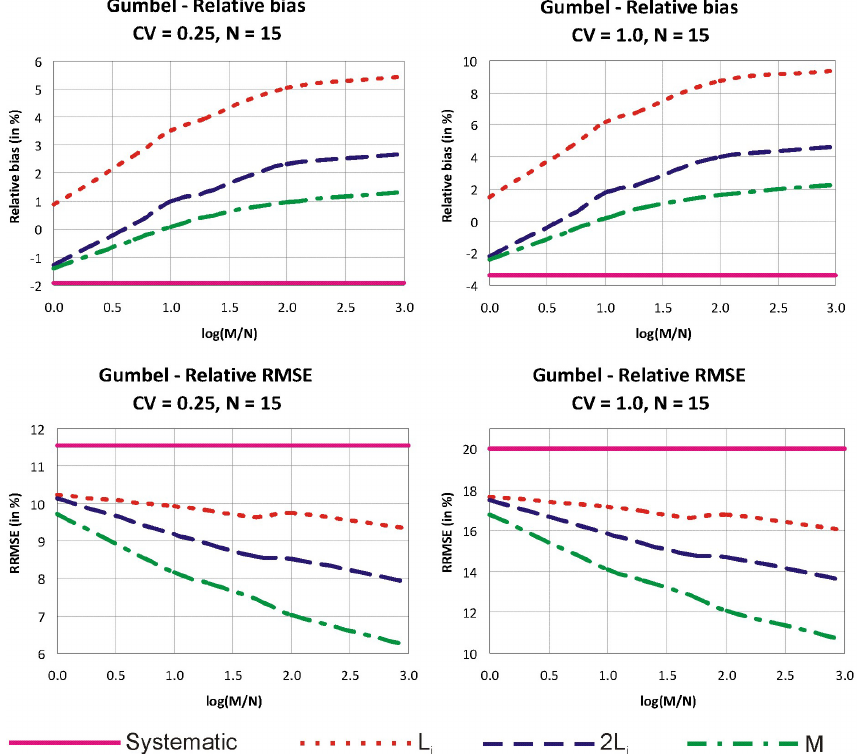
Figure 2. Relative bias (RB) and relative root mean square error (RRMSE) of ˆ X T = 100 as a function of gauge record length N and historic period M for ˆ M i = 0 , L i , 2 L i , M . Parent distribution Gumbel with CV equal: 0.25 and 1.0 and N = 15. Fitted distribution